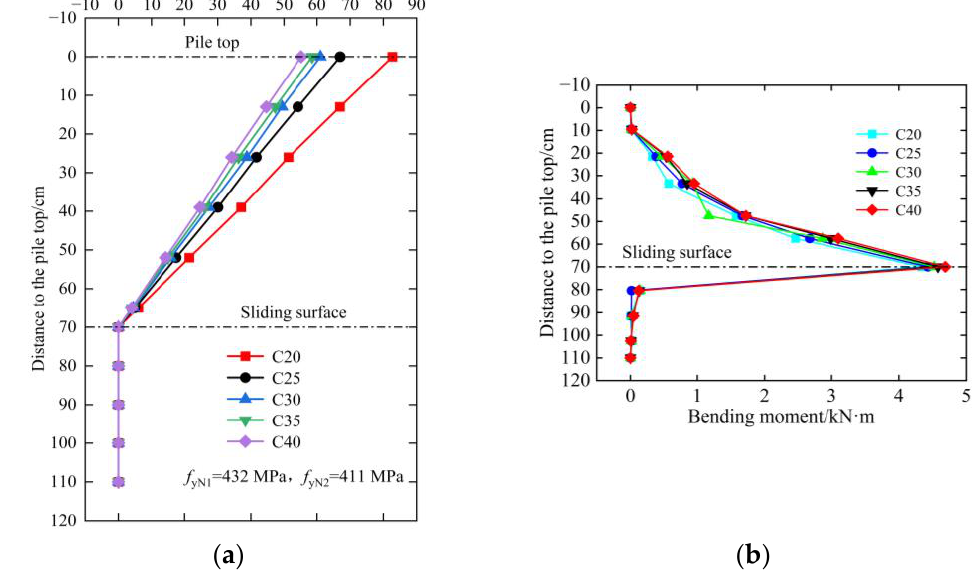
Figure 24. Variations of the pile displacement and bending moment with respect to concrete strength. ( a ) Pile displacement; ( b ) pile bending moment.